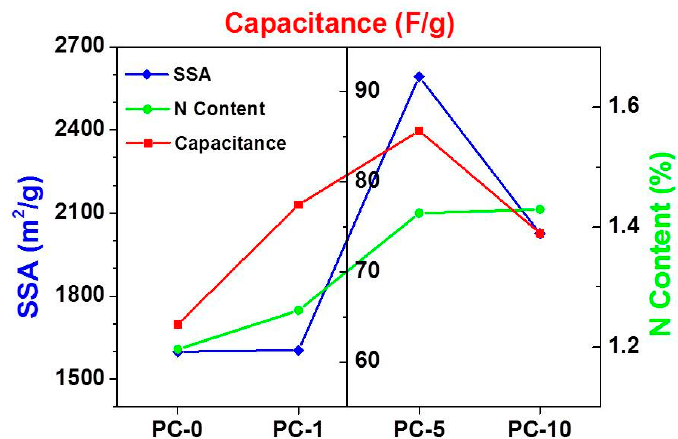
Figure 7. The correlations of SSA (specific surface area), the N content, and the specific capacitance 5 A/g of the at 5 A/g of the samples.